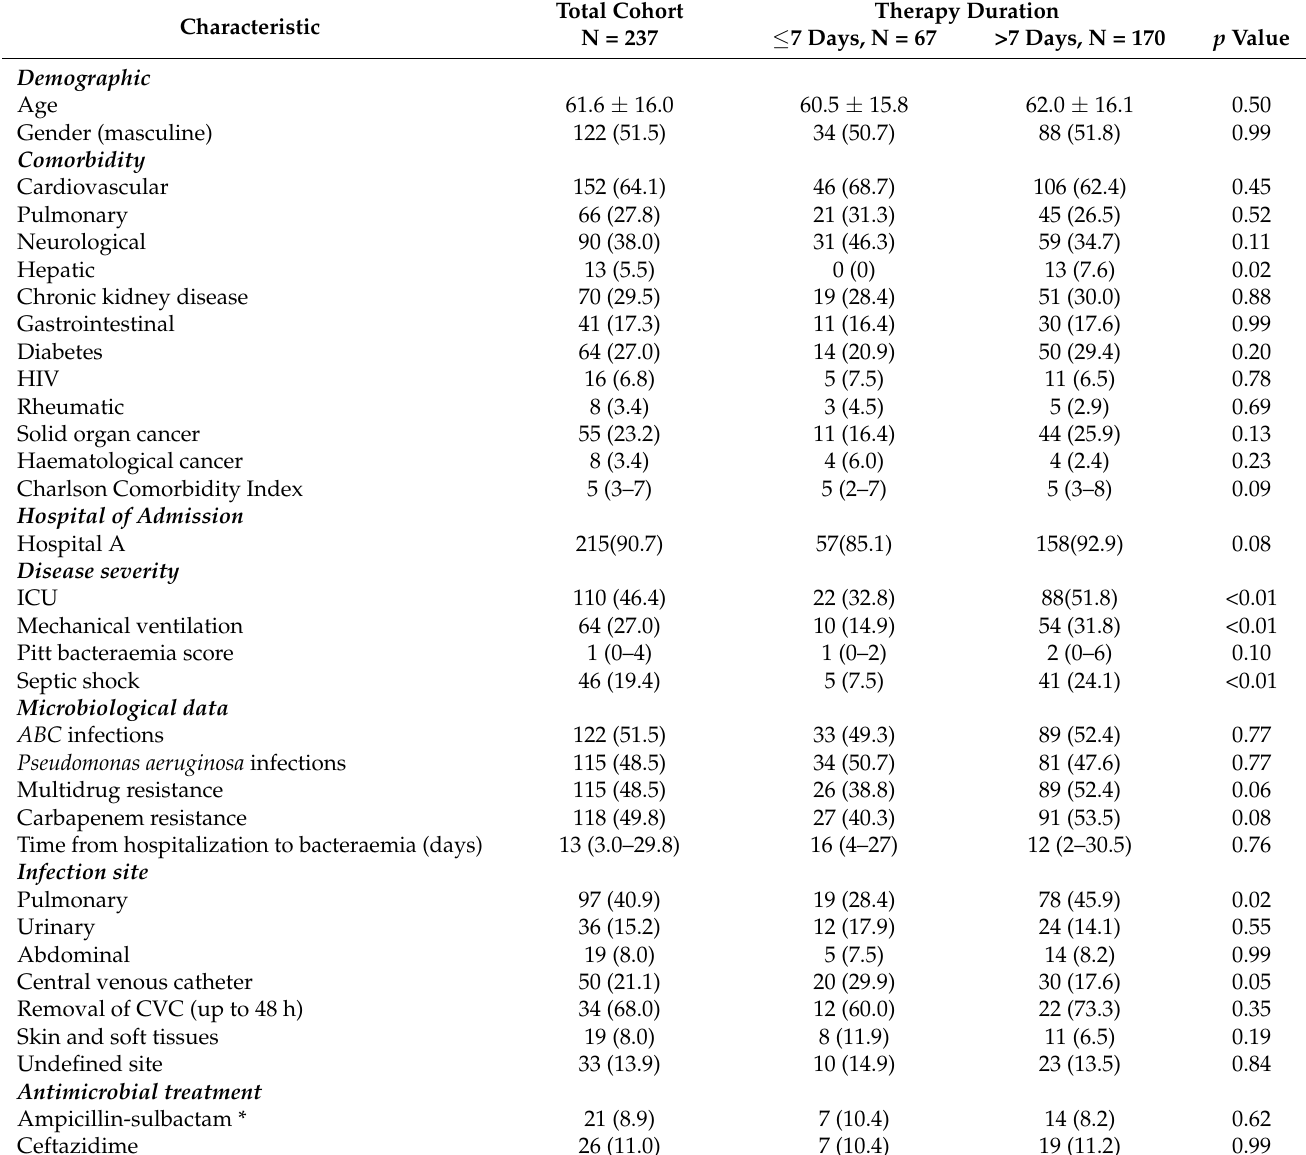
Table 1. Baseline characteristics and univariate analysis comparing short- and long-term therapy groups in patients with Acinetobacter baumannii-calcoaceticus complex and Pseudomonas aeruginosa bloodstream